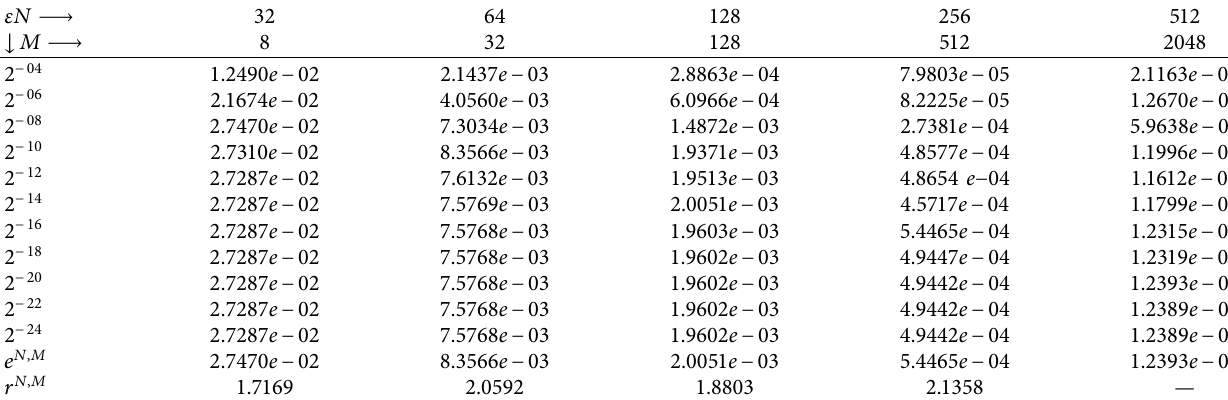
Table 3: Maximum absolute error and rate of convergence for Example